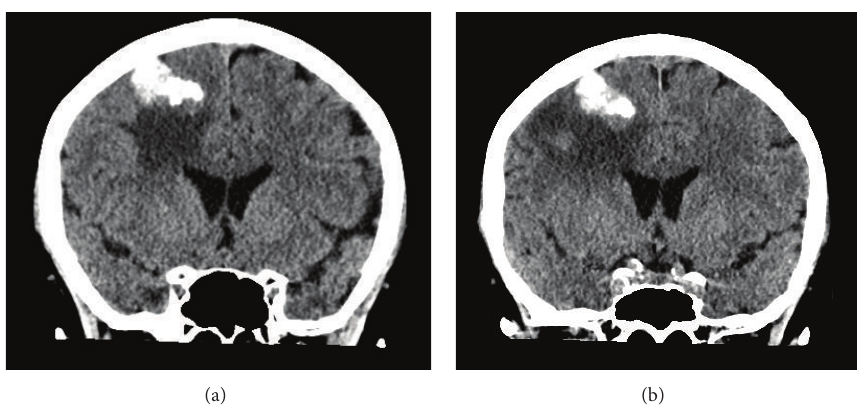
Figure 2: (a) 2014 precontrast CT, coronal view. (b) 2014 postcontrast CT, coronal view.